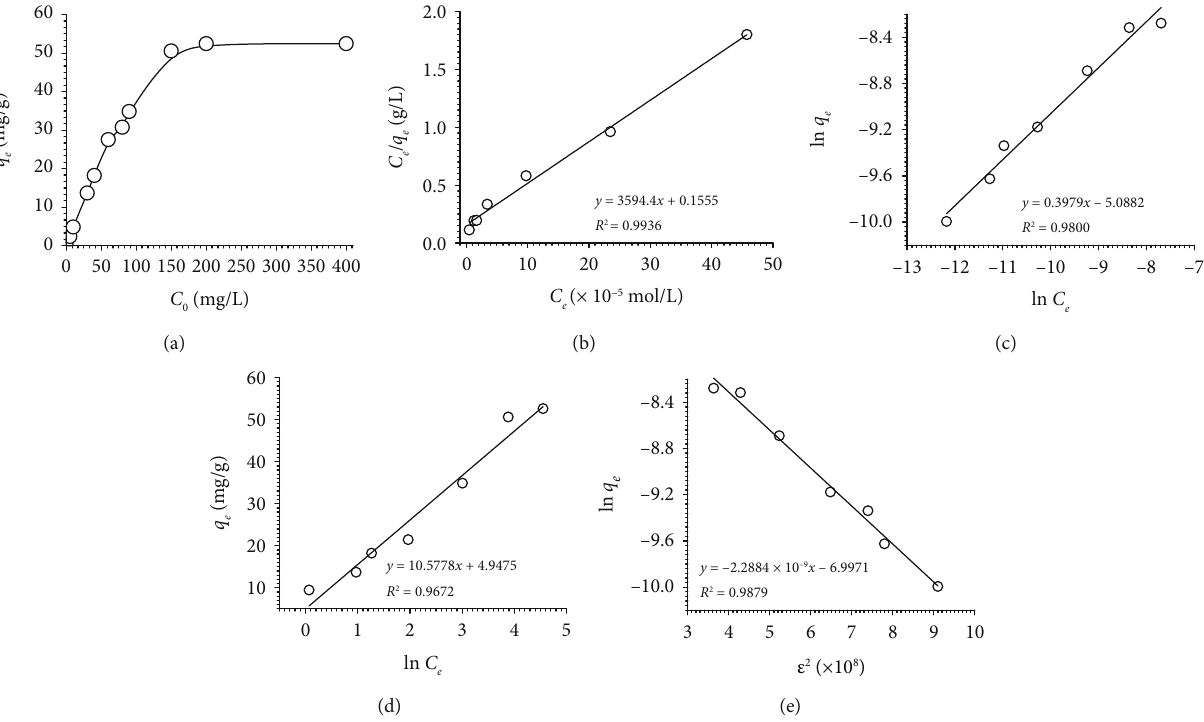
) and the linear plots of (b) Langmuir, (c) Freundlich, 0